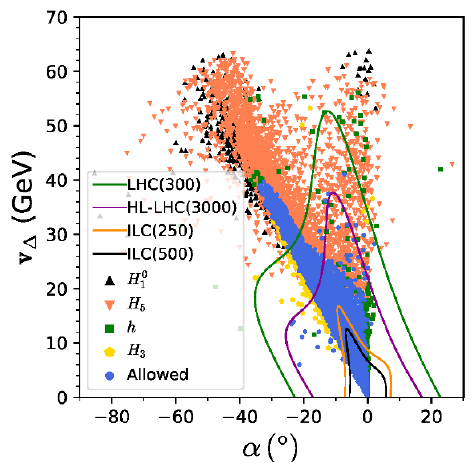
Figure 1 . Distribution of survived points in the (cid:11) (cid:0) v (cid:1) plane under theoretical and indirect constraints generated by GMCALC. The black, red, yellow, and green points are further excluded by direct searches for H 0 , H 5 , and H 3 and by Higgs signal strength analysis respectively, while the 1 circular blue points pass all current constraints. The green, magenta, orange, and black curves are exclusion bounds expected from projection results of 14 TeV LHC with 300 fb (cid:0) 1 , HL-LHC with 3000 fb (cid:0) 1 , and ILC at 250 and 500